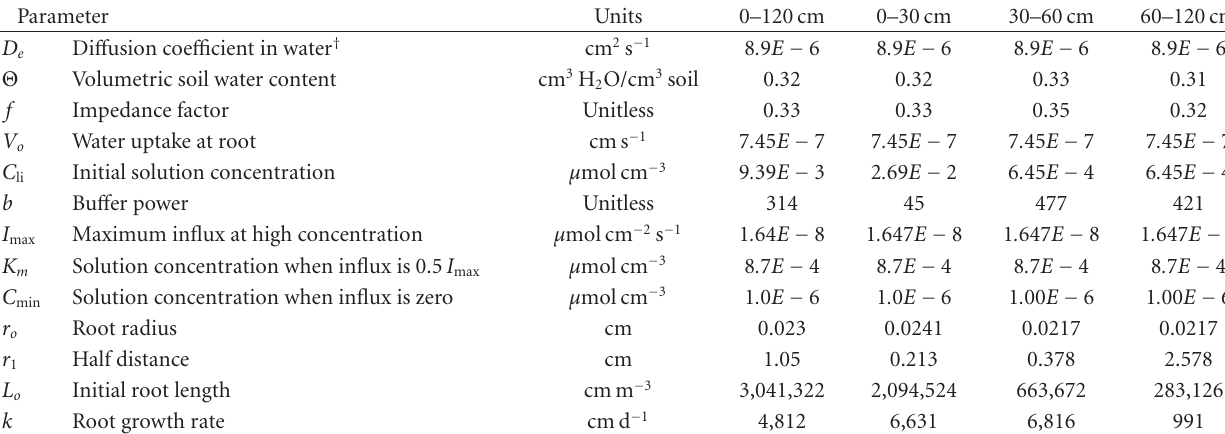
Table 1: Transport, sorption, and root parameters used in the NST 3.0 model to describe P uptake by cottonwood for the 0–120, 0–30, 30–60, and 60–120 cm soil depths.